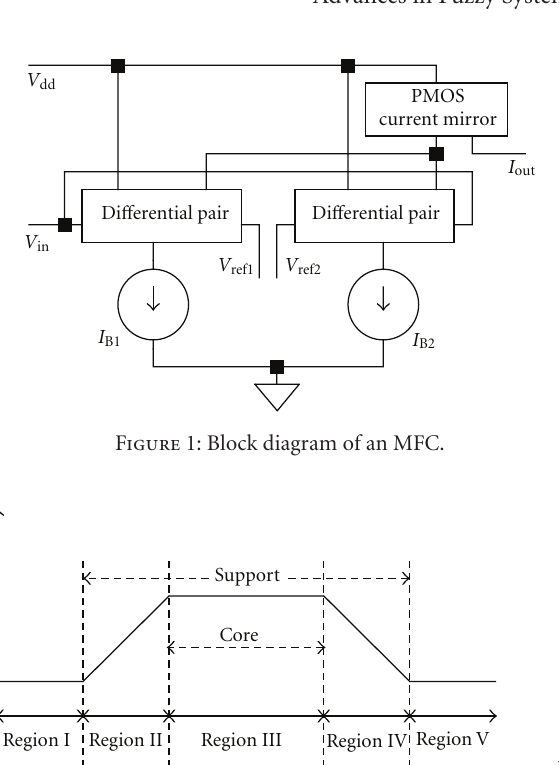
Figure 2: Trapezoidal shape of membership